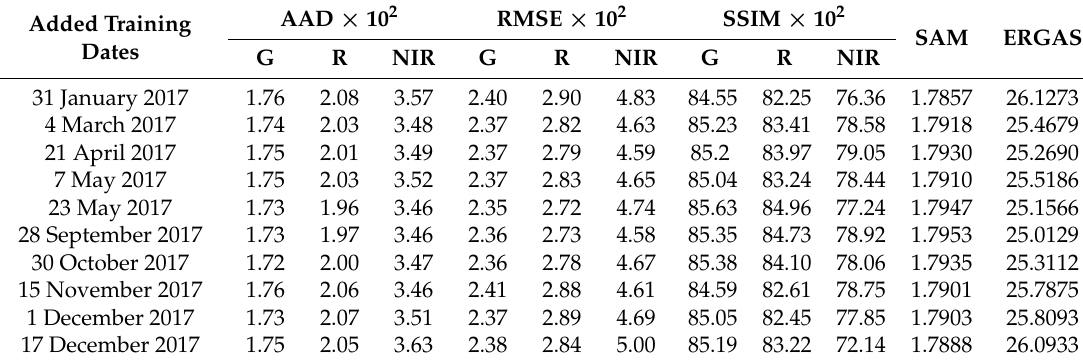
Table 8. Assessment indices from the proposed fusion with the urban data acquired in 2017 for modeling reflectance on 12 September 2017.